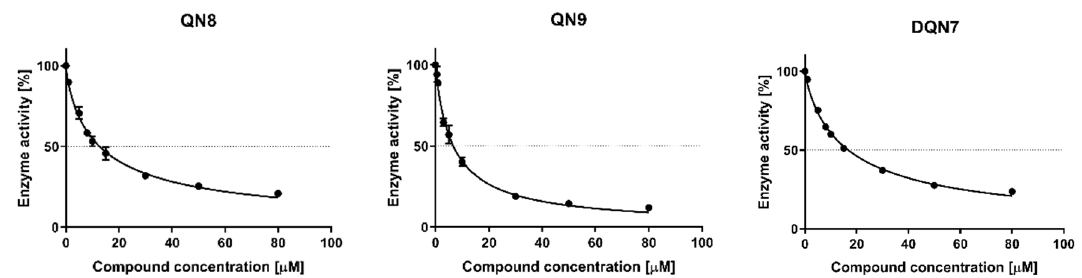
Figure 5. IC 50 determination for hr BuChE inhibition by QN8 , QN9 , and DQN7 .